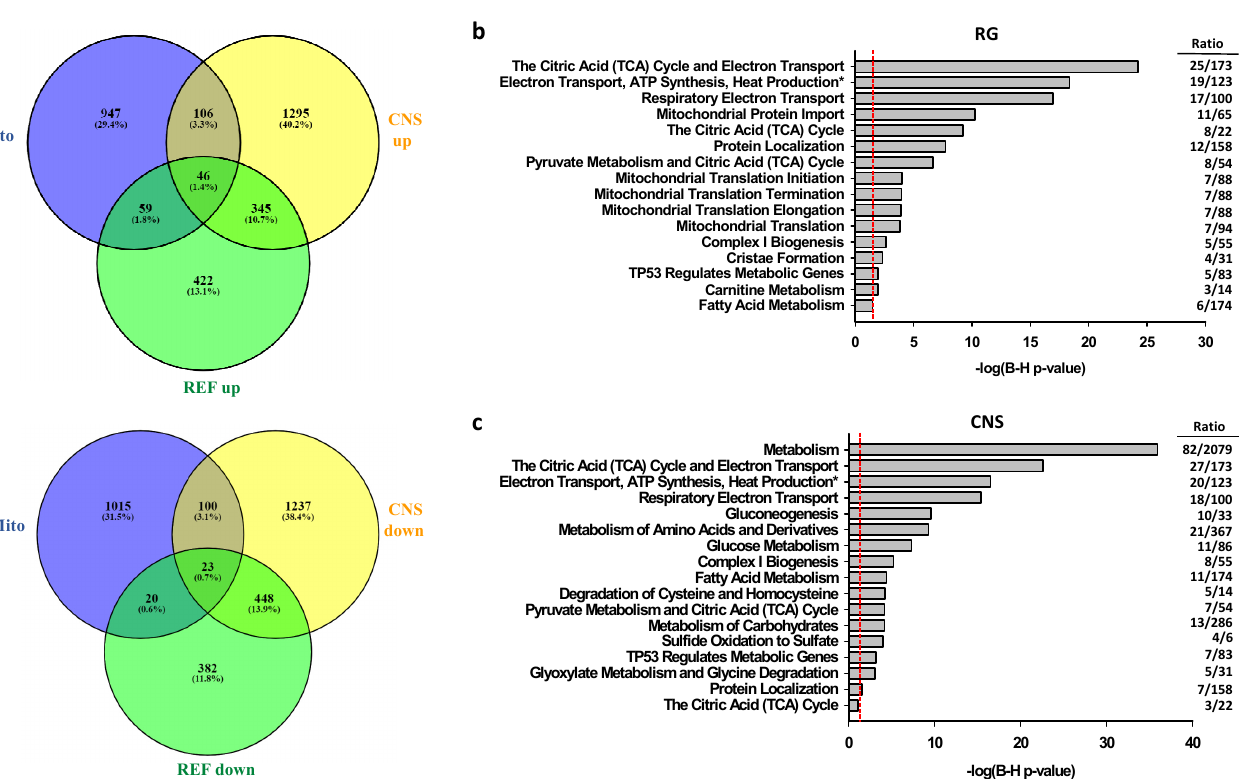
Figure 5. RG and CNS promoter activation induces similar and different changes in mitochondrial genes. ( a ) Venn diagrams of mitochondrial up- (top) or down-regulated genes (bottom); ( b , c ) Reactome pathways deduced from enrichment analyses of up-regulated mitochondrial genes after activation of RG or CNS promoters; * full name: Respiratory electron transport, ATP synthesis by chemiosmotic coupling, and heat production by uncoupling proteins.